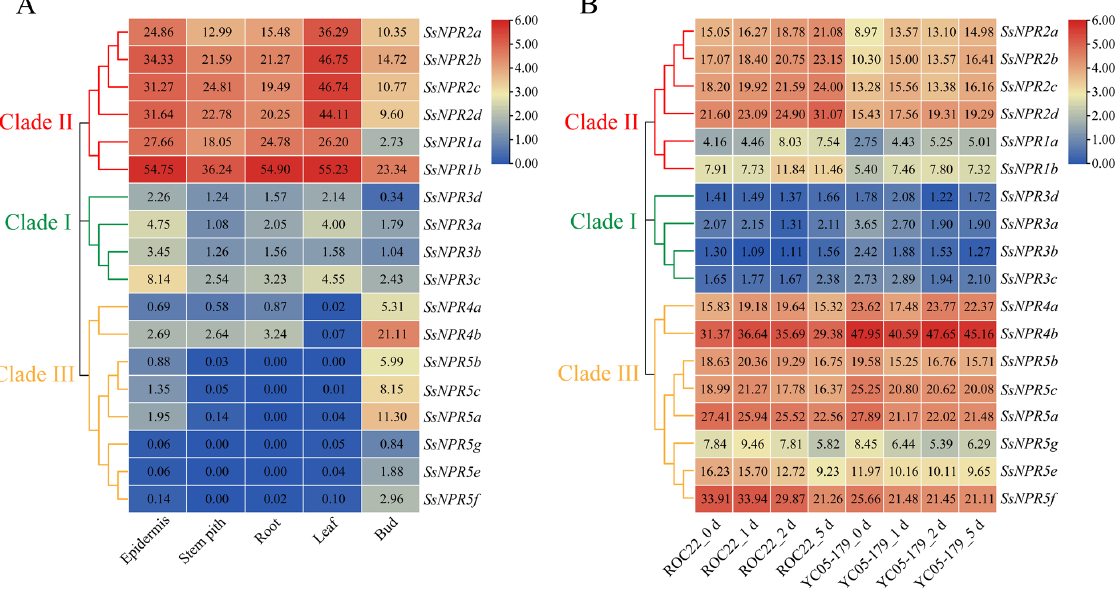
Figure 5. Expression profile of NPR1 -like genes in various tissues of sugarcane and under smut pathogen stress. ( A ) Expression profile of NPR1 -like genes in different tissues of sugarcane hybrid ROC22. ( B ) Expression profile of NPR1 -like genes in the interaction between different sugarcane genotypes and Sporisorium scitamineum . ROC22_0 d/1 d/2 d/5 d represents the sugarcane smut-susceptible variety ROC22 under S . scitamineum treatment for 0 d, 1 d, 2 d, and 5 d, respectively. YC05–179_0 d/1 d/2 d/5 d represents the sugarcane smut-resistant variety YC05–179 under S . scitamineum treatment for 0 d, 1 d, 2 d, and 5 d, respectively. The clustering tree on the left side of the figure is constructed using MEGA X with the neighbor method, and different colors on the phylogenetic tree represent different NPR1-like clades. The expression heatmap of NPR1 -like genes is constructed by TBtools with the transcript level transformed by log2 (FPKM). The FPKM is the number of fragments per kilobase of transcript per million mapped, and its value is displayed in each heatmap box.